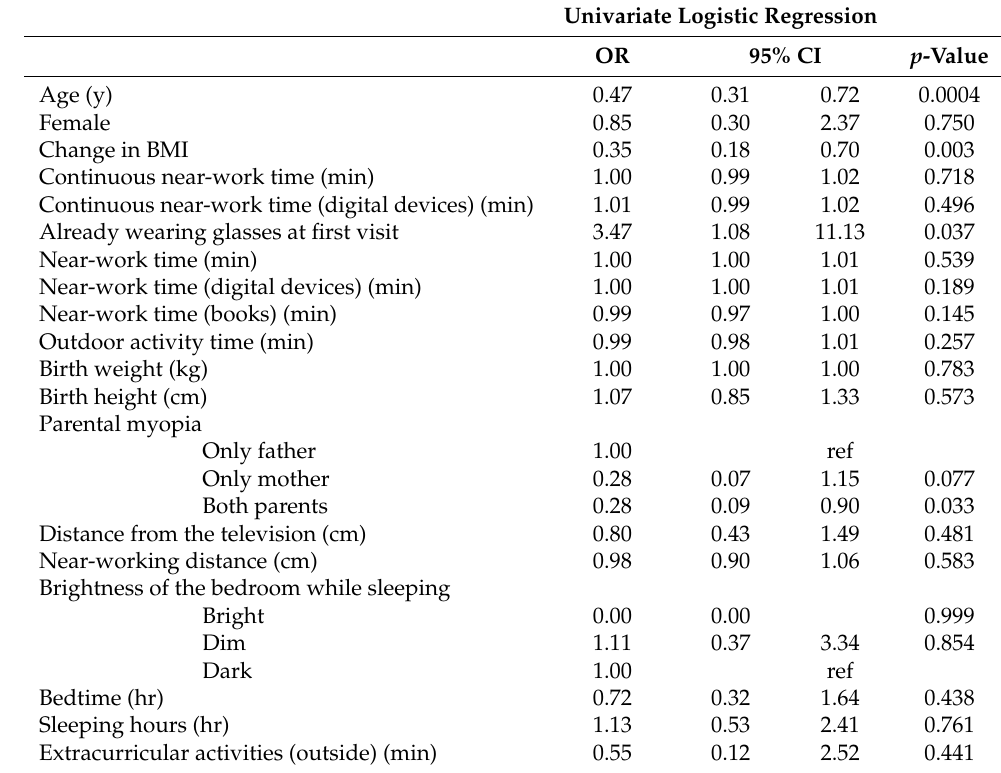
Table 4. Factors for decrease in spherical equivalent power of − 2.5 D or